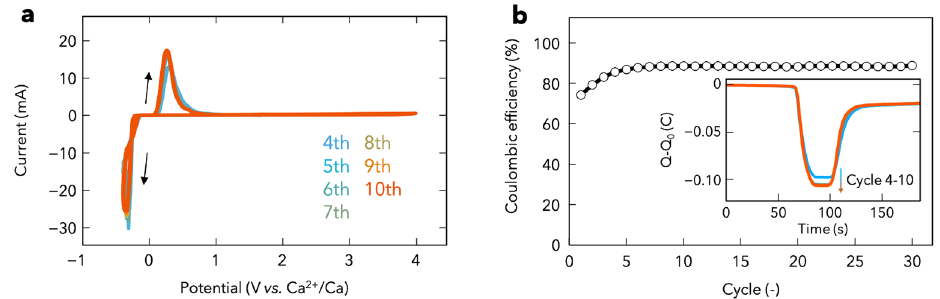
Figure 2. ( a ) Cyclic voltammograms of Ca plating/stripping after conditioning cycles at 20 mV s −1 with a three electrode setup using Au as the working electrode and Ca as the reference and counter electrodes at room temperature. Cyclic voltammograms for initial three cycles as conditioning processes are shown in Fig. S6. ( b ) Coulombic efficiency determined from the cyclic voltammograms. Inset: charge balance for cycles